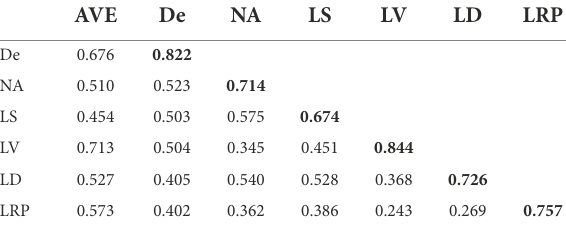
Bartlett’s test